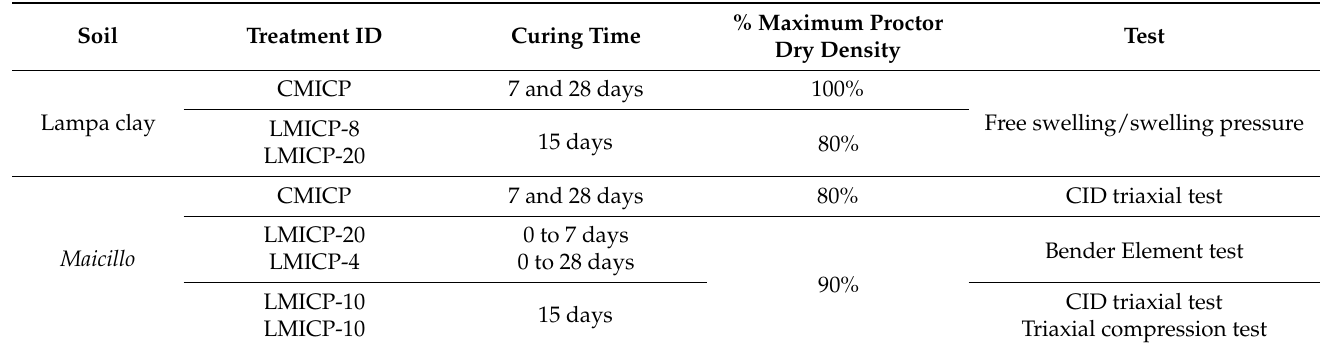
Table 3. Laboratory tests for treated samples.